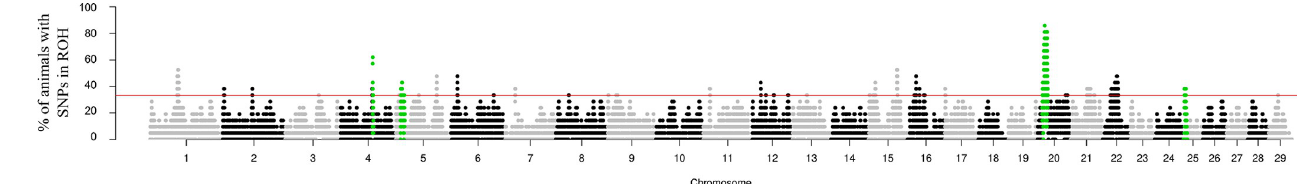
Fig 5. Genome-wide ROH hotspots disribution in GWH breed. The y-axis represents the percentage (%) of animals with SNPs in ROH regions and the x- axis the genomic coordinate of each variant. The significance threshold indicating the genomic regions (ROH hotspots) containing the variants present in more than 99% of a ROH region across the samples is indicated by the red line. Green dots represent genomic regions on BTA4 (70.2–71.3 Mb), BTA5 (10.0–19.7 Mb), BTA20 (10.0–19.9 Mb and 20.0–22.7 Mb), and BTA25 (0.5–9.2 Mb) that co-localize with significant SNPs commonly detected by the GWAS, selective sweeps and ROH